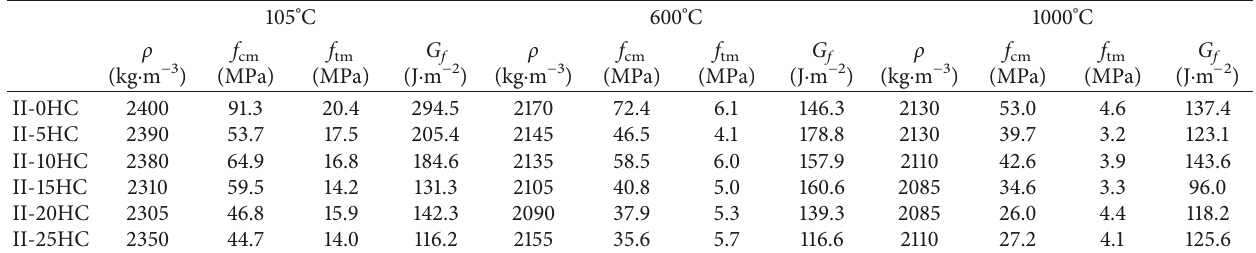
Table 4: Basic and mechanical properties of hydrothermally cured